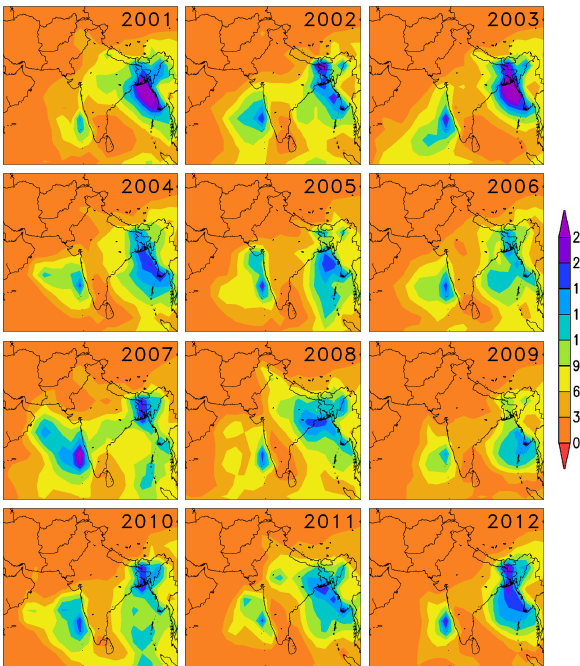
Figure 10. GPCP monthly mean precipitation in June for the years 2001–2012 over the region bounded by 5 to 40 ◦ N and 50 to 100 ◦ E.